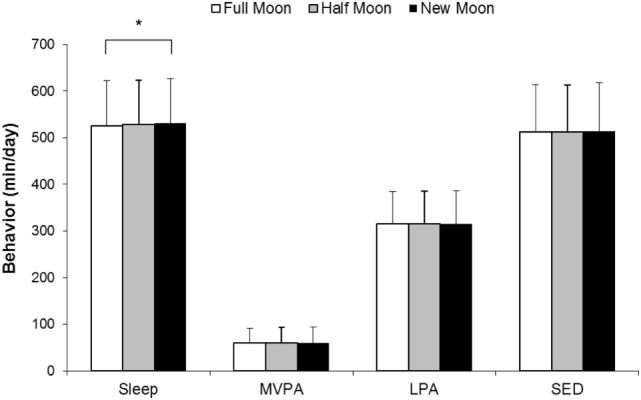
Sleep and activity behaviors according to moon phases. Data are presented as mean values and SDs. A multilevel linear mixed model was used with participants and schools as random effects and sites as fixed effects. The model was adjusted for age, sex, highest parental education, day of measurement, and body mass index z-score. Full moon (±4 days; includes 30% of observations), half moon (±5–9 days from full moon; includes 33% of observations), and new moon (±10–14 days from full moon; includes 37% of observations). *Sleep duration is significantly shorter during “full moon” compared to “new moon” (P < 0.01). MVPA, moderate-to-vigorous physical activity; LPA, light-intensity physical activity; SED, sedentary time.